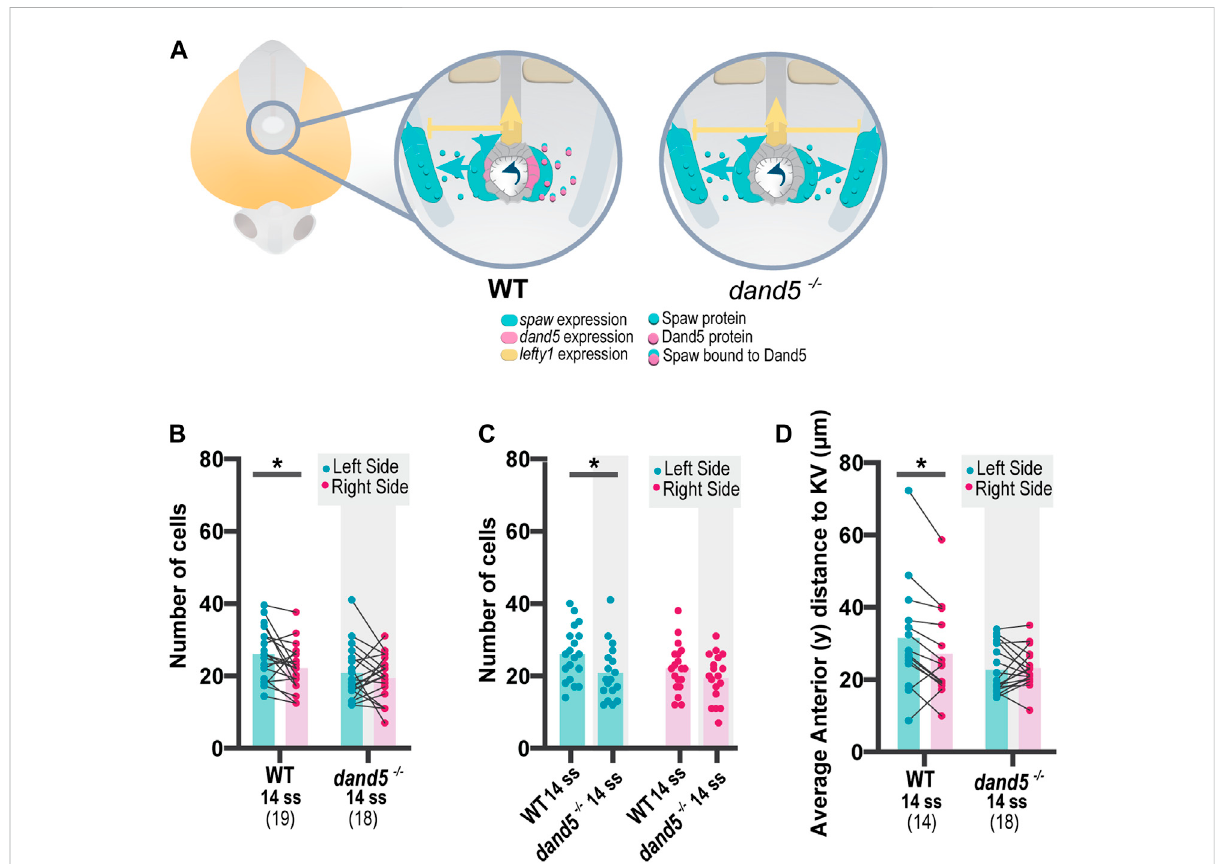
FIGURE 3 Quanti fi cationofNKSTCs distribution patternsinWTand dand5 − / − embryos. (A) Schematicrepresentation ofearlyasymmetricestablishmentin WTand dand5 − / − embryos.Intheabsenceof dand5 expression,SpawfreelytravelstobothsidesoftheLPM,whereitactivatesitsownexpressionand its inhibitor lefty1 at the midline. (B) Quanti fi cation of left-right differences in the number of NKSTCs at 14 ss in WT and dand5 − / − embryos. (C) Quanti fi cation of differences in the number of NKSTCs observed on each side of the embryos at 14 ss in WT and dand5 − / − embryos. (D) Quanti fi cationofleft-rightdifferencesobservedintheanteriordistancetotheKVbasedonthe3DcoordinatesofNKSTCsat14ssinWTand dand5 − / − embryos. Cyan represents the left side, and magenta represents the right side. t -test paired and unpaired comparisons. Bars represent mean values, and dots represent individual embryos. * Corresponds to a p -value <